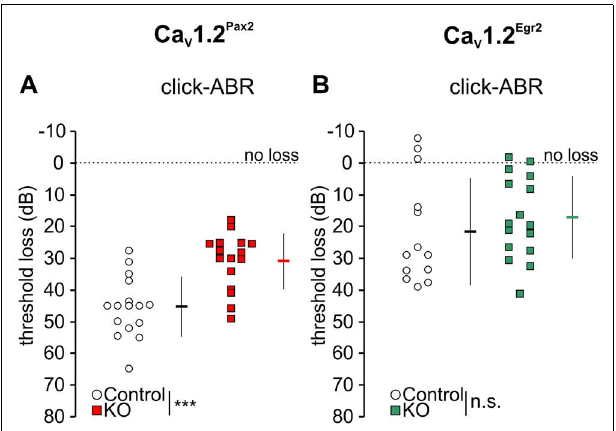
FIGURE 4 | Mild loss of click-ABR threshold in Ca V 1.2 Pax2 KO mice after noise exposure. (A) Mean ± SD click-ABR threshold losses for Ca V 1.2 Pax2 controls (black horizontal dash, 45.3 ± 9.51, n = 16 ears, 8 mice, single ear threshold losses as white circles) and Ca V 1.2 Pax2 KO mice (red horizontal dash, 30.9 ± 8.87, n = 16 ears, 8 mice, single ear threshold losses as red squares) 7 days after noise exposure showing a significantly milder threshold loss (14.5 dB difference; two-sided Student’s t -test: p < 0.001) in Ca V 1.2 Pax2 KO mice. (B) Mean ± SD click-ABR threshold losses for Ca V 1.2 Egr2 controls (black horizontal dash, 21.6 ± 16.8, n = 13 ears, 7 mice, single ear threshold losses as white circles) and Ca V 1.2 Egr2 KO mice (green horizontal dash, 17.2 ± 12.9, n = 16 ears, 8 mice, single ear threshold losses as green squares) 7–11 days after noise exposure, showing similar threshold loss (4.4 dB difference; two-sided Student’s t -test: p = 0.431). Dotted lines at 0 dB represent no threshold loss after noise exposure.